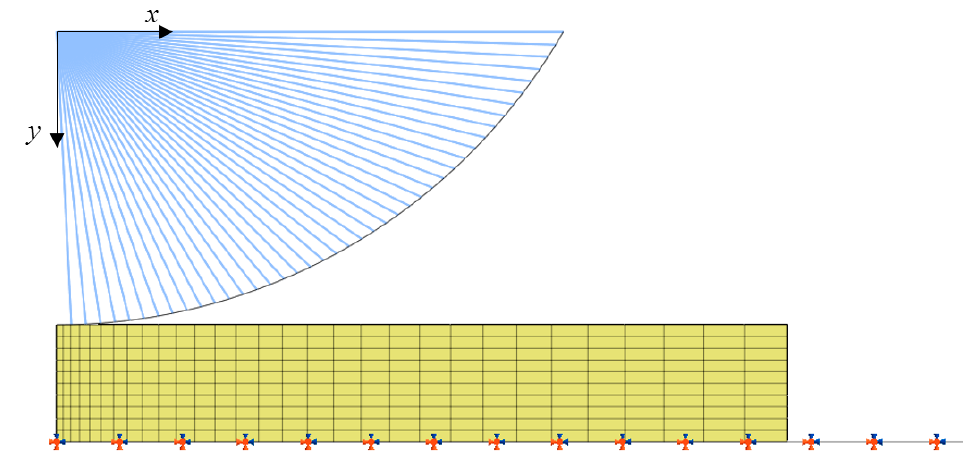
Figure 2. FE model of cylindrical impactor type.